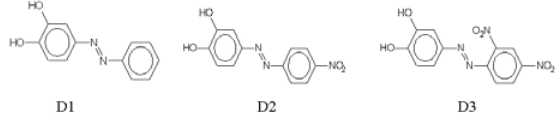
Figure 1. Structural features of azo dyes